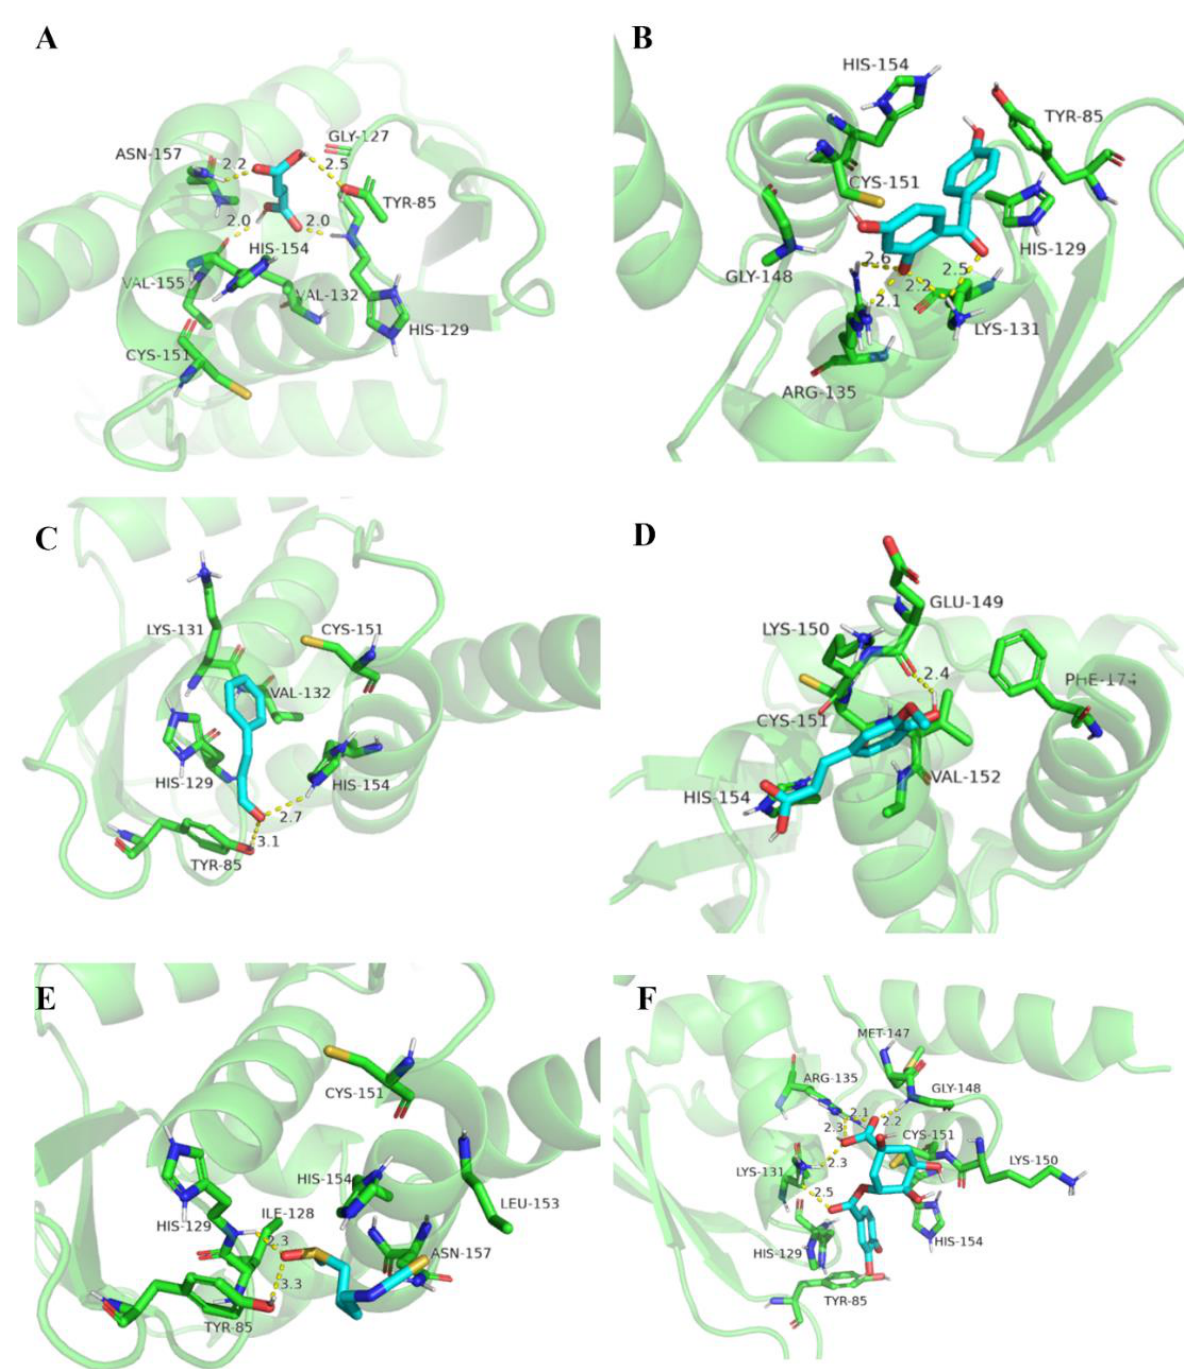
Figure 5. Molecular docking of FECs and BTB domain of Keap1. ( A ) FMA; ( B ) ISO; ( C ) CA; ( D ) FA; ( E ) SFN; ( F ) CGA.